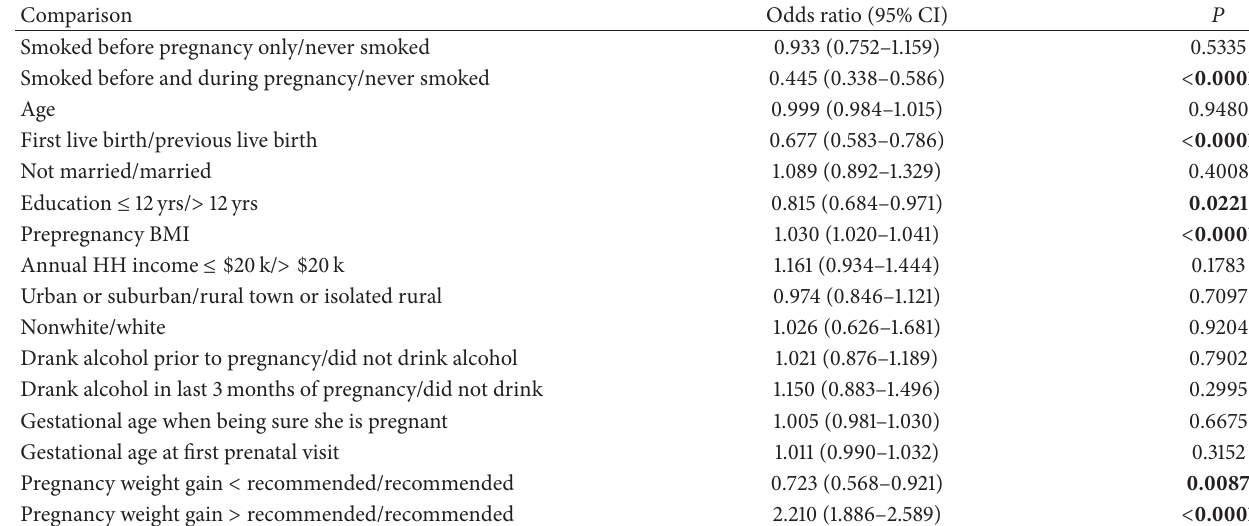
Table 4: Maternal predictors of excessive ( ≥ 4000 gms) versus normal birth weight.